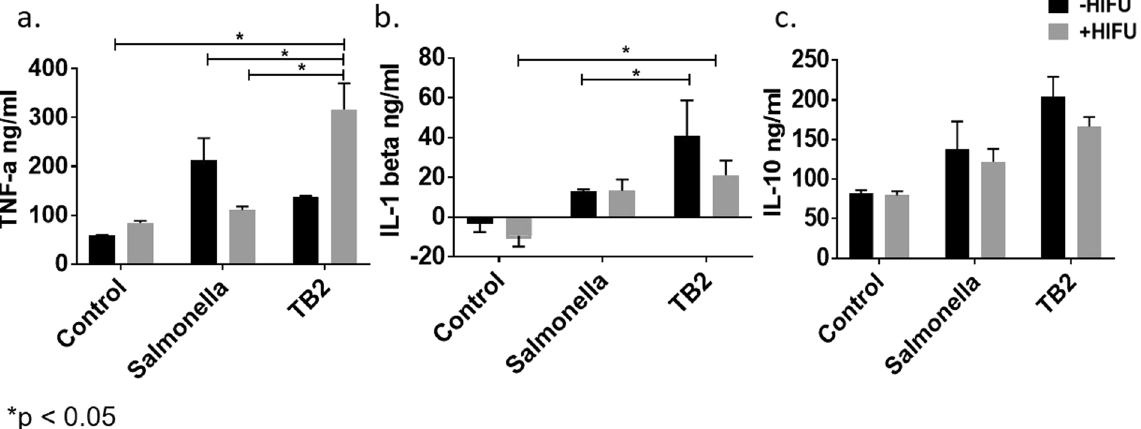
Figure 6. Enhancement of pro-inflammatory cytokines in serum with TB treatment. ELISA was performed to detect the serum cytokine levels of TNF- α , IL1- β and IL-10. ( a ) TB2 + HIFU increased TNF- α serum cytokine level compared to control, Salmonella and TB treatment at 37 and 42 °C; ( b ) IL-1 β serum levels increased by 2–3 fold for TB treatment compared to controls; ( c ) IL-10 levels were increased by 2–3-fold by HIFU/TB compared to controls. Values represent means ± SEM (n = 4, * p <